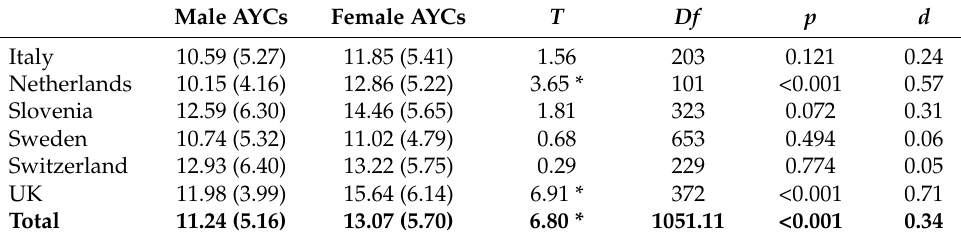
Table 6. T -tests on mean MACA score (SD) for male and female AYCs, separately for each